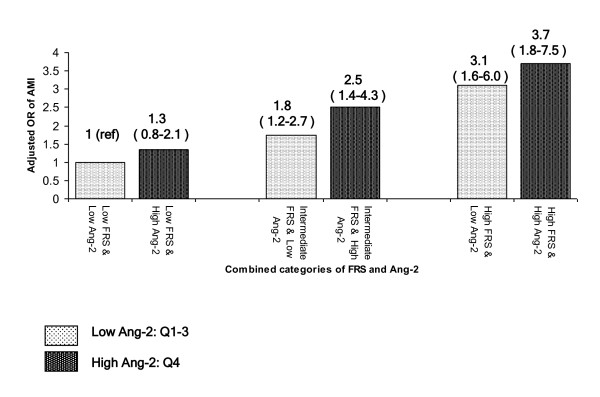
Combined Effect of 10-year Framingham Risk and Ang-2 on Odds Ratio of AMI. Low Ang-2 (light pattern) defined as quartiles 1 through 3; high Ang-2 (heavy pattern) defined as quartile 4.